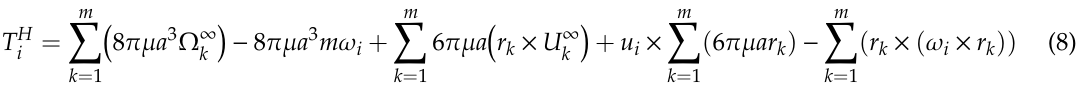
(cid:44) 0 when the distance between two segments is